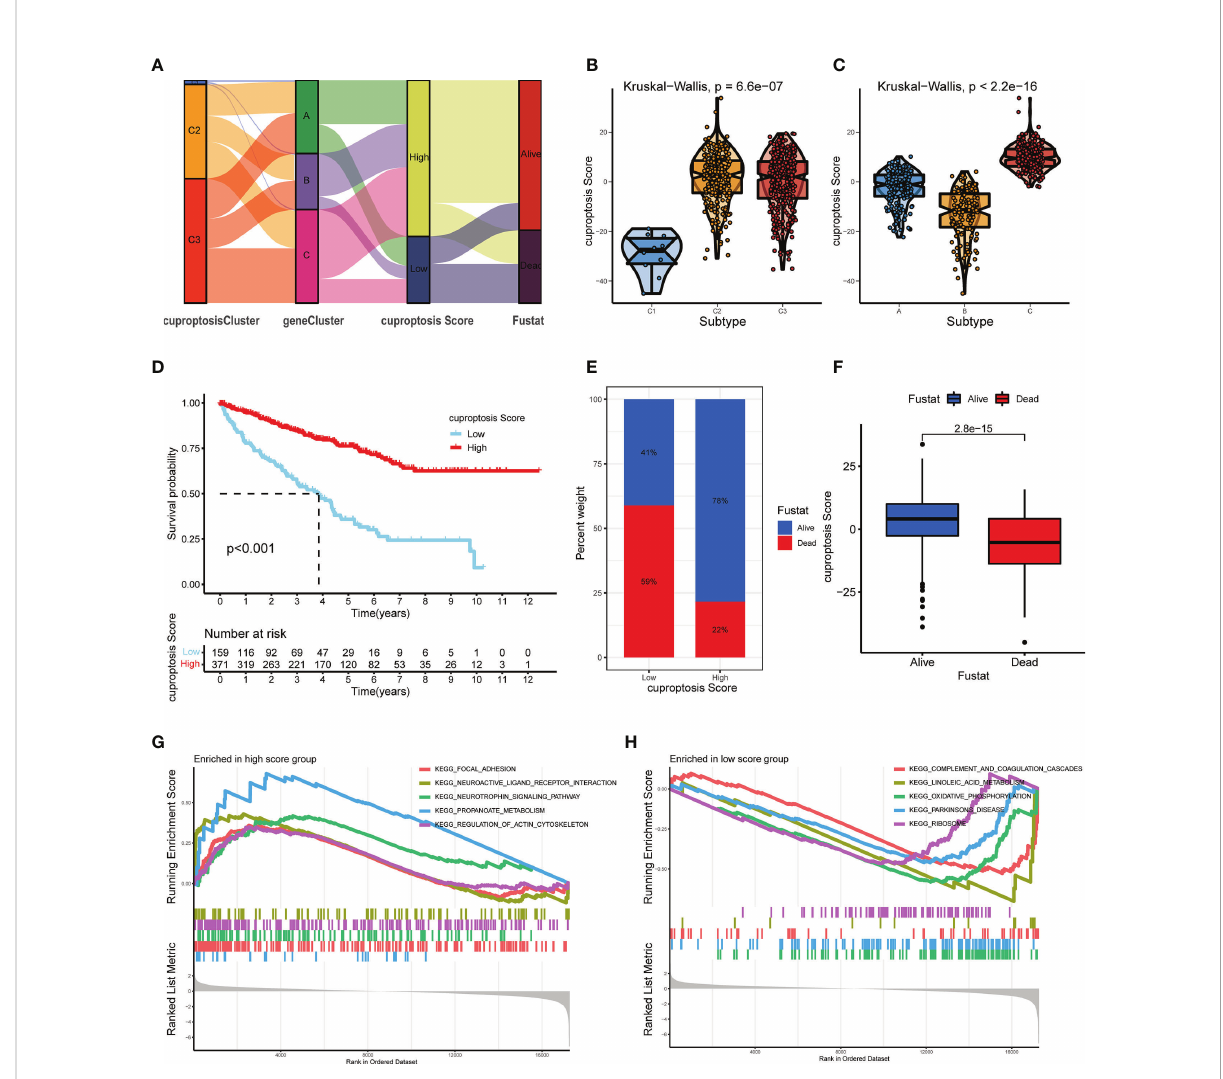
FIGURE 7 Construction and veri fi cation of the cuproptosis score for ccRCC patients from TCGA database. (A) Distribution of ccRCC patients in groups based on CAGs, DEGs, cuproptosis score, and surviving status. (B, C) Cuproptosis score of diverse subgroups based on CAGs (B) and DEGs (C) . (D) Kaplan – Meier survival curves of ccRCC patients with low and high cuproptosis scores. (E) Proportion of dead or alive patients in low and high cuproptosis score groups. (F) Overall level of cuproptosis score for patients in alive and dead groups. (G, H) KEGG pathway analysis on patients in low and high cuproptosis score groups ( p < 0.05 *; p < 0.01 **; p < 0.001 ***). CAGs, cuproptosis-associated genes; DGEs, differentially expressed